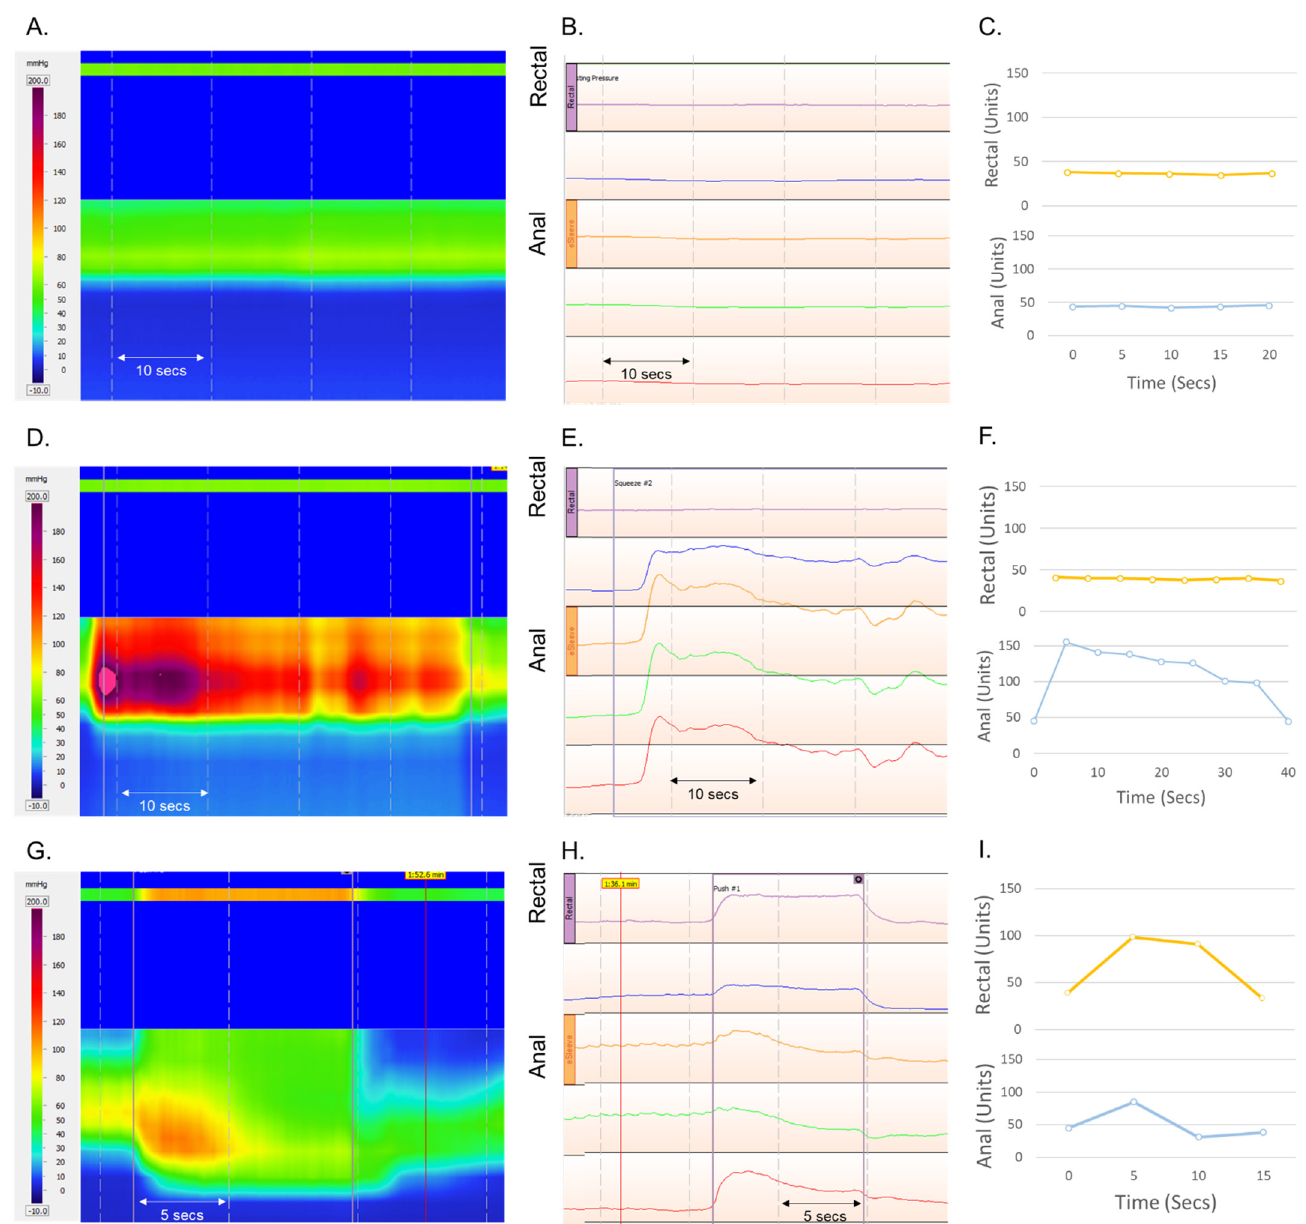
Figure 9. Biofeedback manoeuvres profiles depicted using high-definition anorectal manometry (HD-ARM) presented as a detailed topographical plot and waveform plot (rectal and eSleeve sensor outputs labelled), and new IoMT graphically presented as units over time in rectal and anal sensors. ( A – C ) Resting baseline pressures over 20 s. ( D – F ) Squeeze and hold manoeuvre up to 30 s. ( G – I ) Simulated defecation, push